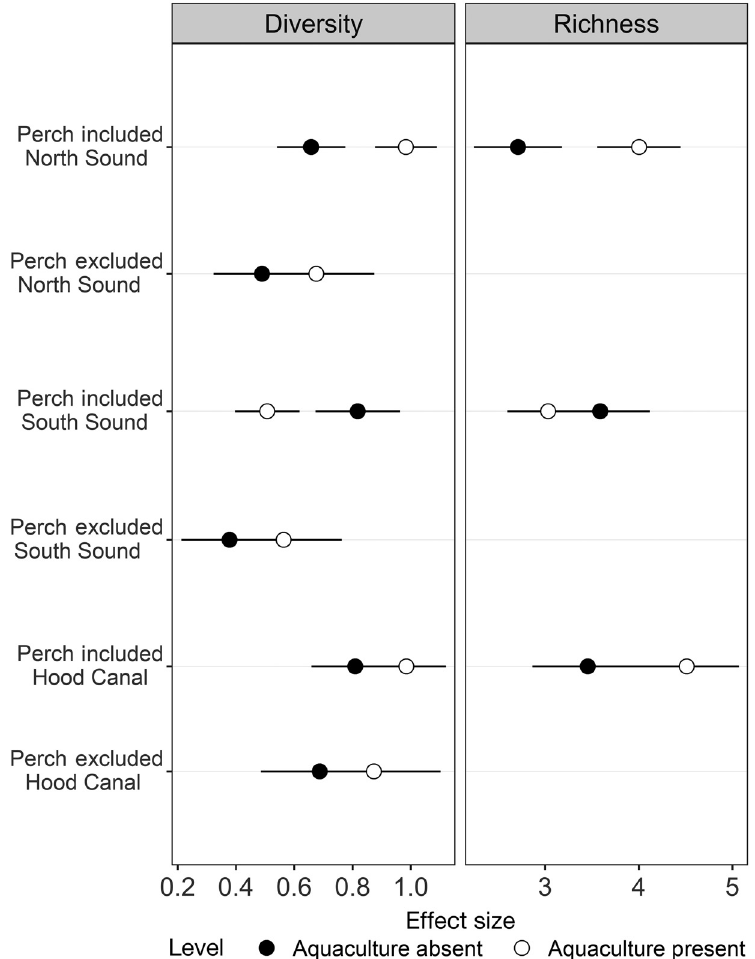
Fig. 5. Predicted Shannon-Wiener diversity index and species richness ef- fect sizes based on general linear mixed models with region and aquacul- ture presence as fixed, interactive effects, and site as random effect. Models were run including and excluding surfperch. Aquaculture present includes clam, oyster on-bottom, and oyster in flipbags mesohabitats. Aquaculture absent includes sediment and eelgrass mesohabitats. Error bars represent SE. Note only species richness in North Sound (perch included) is statisti- cally different when applying post hoc analysis to the general linear